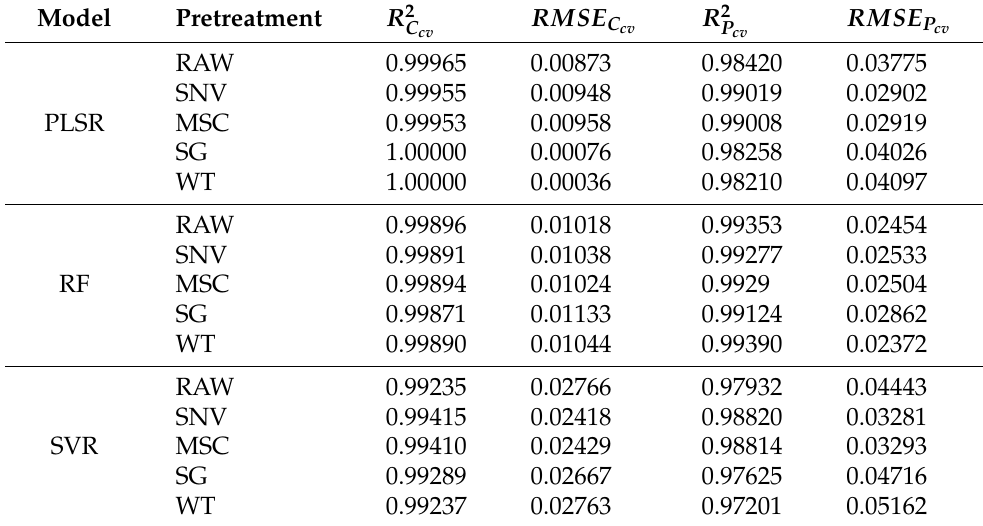
Table 3. Prediction results of rapeseed oil adulterated with soybean oil using full wavelengths.